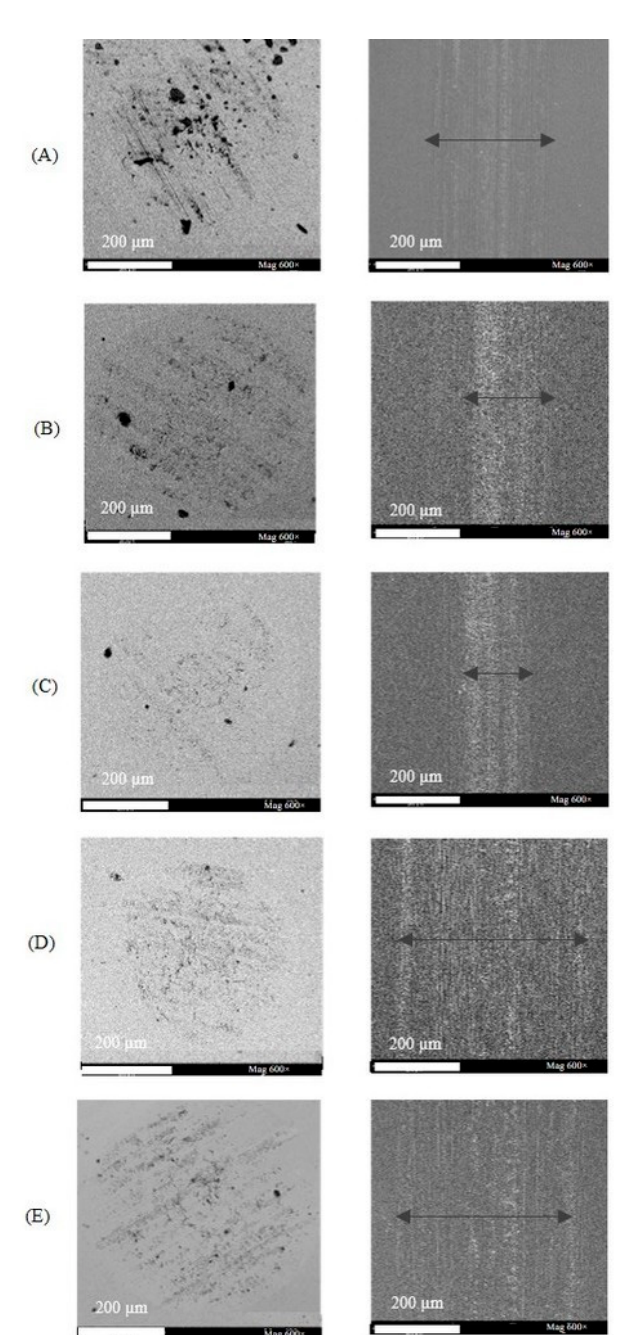
Figure 6. FEG-SEM images with 600 × amplification of the worn surfaces of the Si balls and the Si substrates after long tribological tests under the load of 4 N using as lubricants: PEG200 ( A ), PEG200 + 2% [4-picH][MeSO 3 ] ( B ), PEG200 + 2% [4-picH][HSO 4 ] ( C ), PEG200 + 2% [DBUH][MeSO 3 ] ( D ) and PEG200 + 2% [DBUH][HSO 4 ] ( E ). The black arrows mark the limits of the wear tracks.